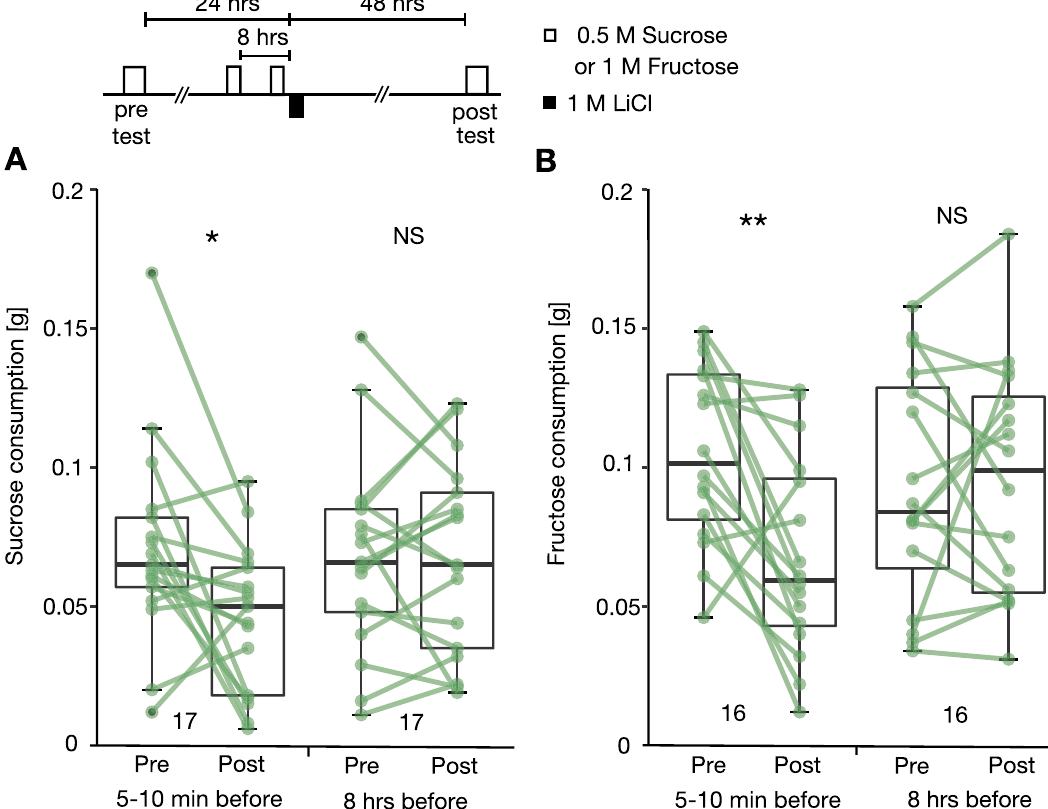
Figure 4. Effects of CTA training with sucrose or fructose solution tested 2 days after LiCl injection. ( A ) Two groups of crickets received a 0.5 M sucrose consumption test, and the next day they were allowed to ingest 100 µm of 0.5 M sucrose solution 5–10 min or 8 h before LiCl injection. Their sucrose consumption was tested again 48 h after LiCl injection. ( B ) Another two groups received CTA training and testing with 1 M fructose solution. The Wilcoxon test was used for statistical comparisons of amounts of sugar consumption 24 h before and 48 h after CTA training (*P < 0.05, **P < 0.01, ns: not